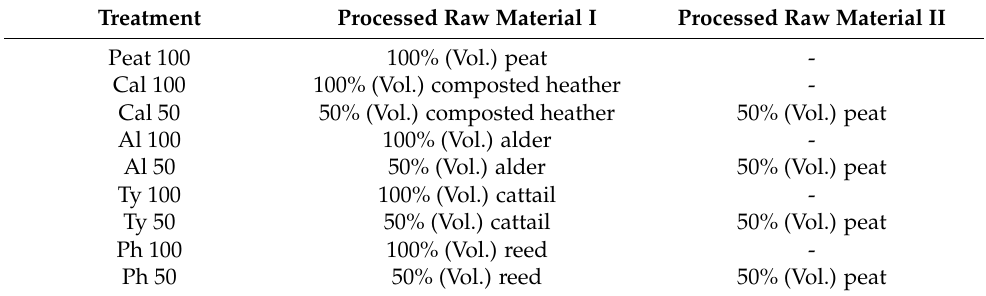
Table 1. Treatments and mixing ratios in stage